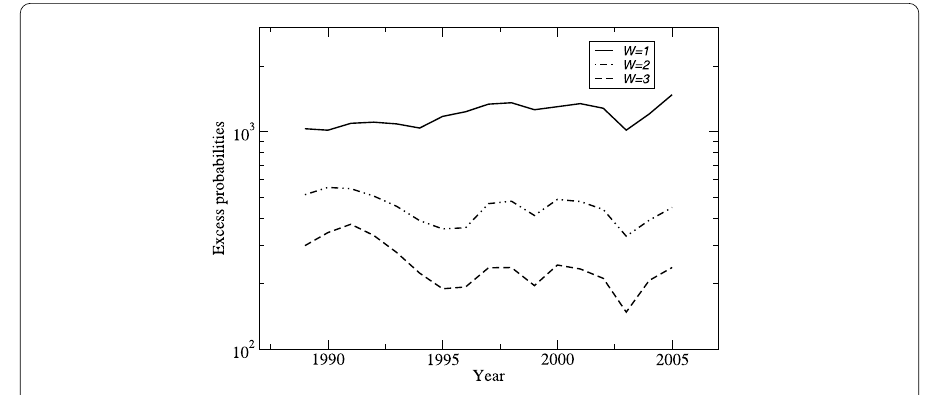
Figure 3 Excess probability x W for W = 1 (—), W = 2 (– · · –), and W = 3 (– – –)